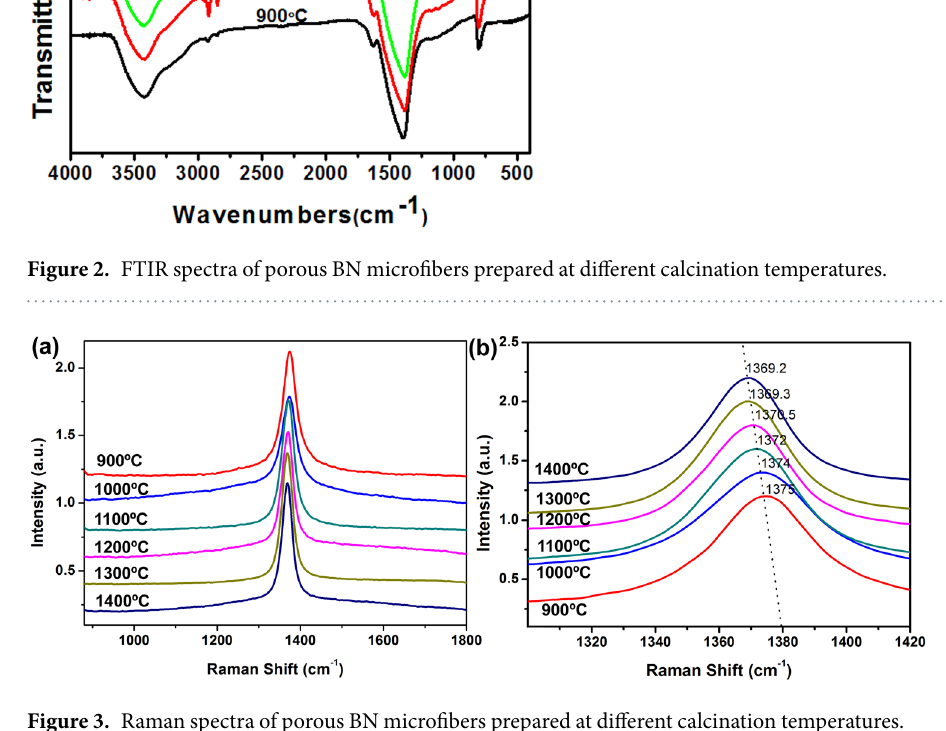
Figure 3. Raman spectra of porous BN microfibers prepared at different calcination